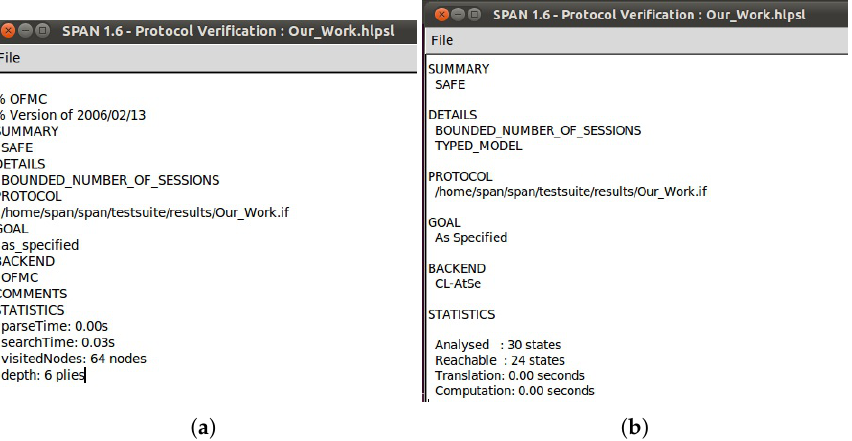
Figure 5. The simulation results under OFMC and CL-AtSe back-ends. ( a ) OFMC back-end; ( b ) CL- AtSe